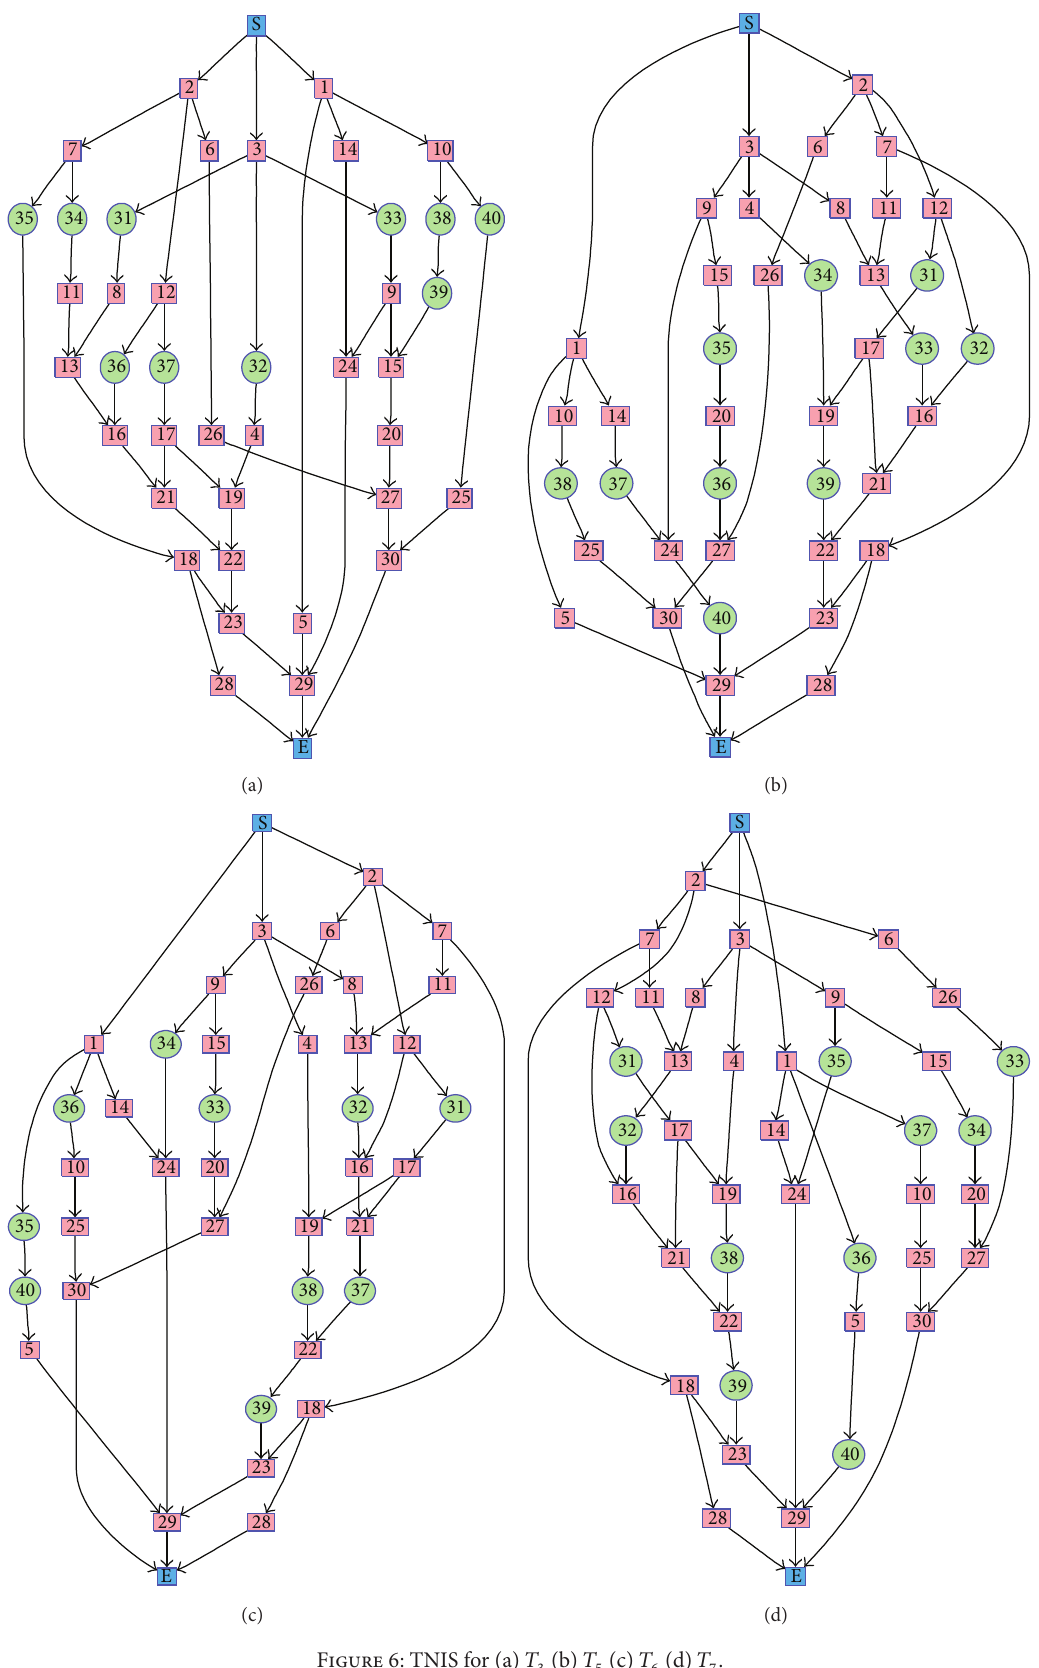
Figure 6: TNIS for (a) 𝑇 3 (b) 𝑇 5 (c) 𝑇 6 (d) 𝑇 7